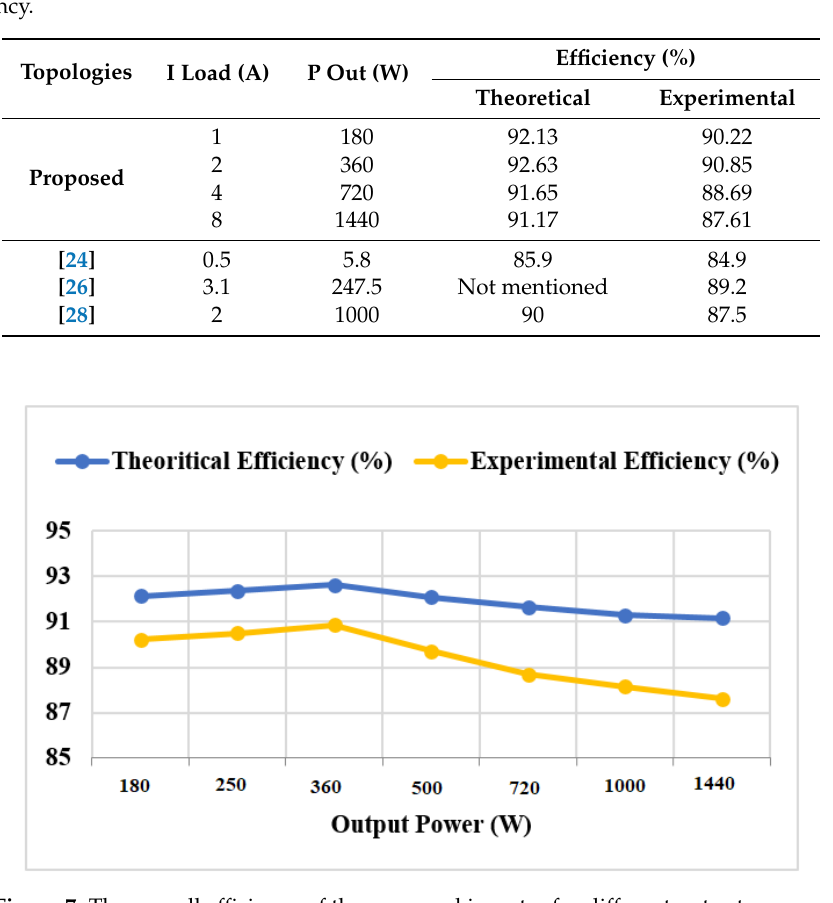
Figure 7. The overall efficiency of the proposed inverter for different output powers.